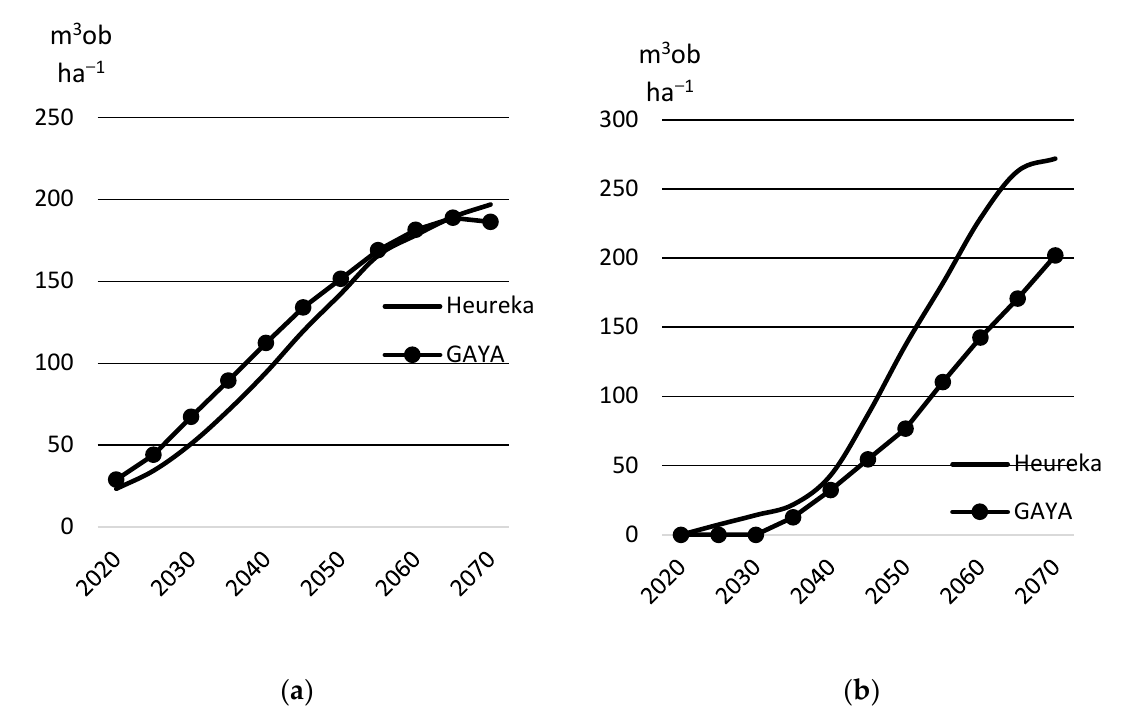
Figure 7. Mean standing volume for Heureka and GAYA for land whose initial state is classified as young ( a ) and mean standing volume for land that is clear cut during the first period ( b ).